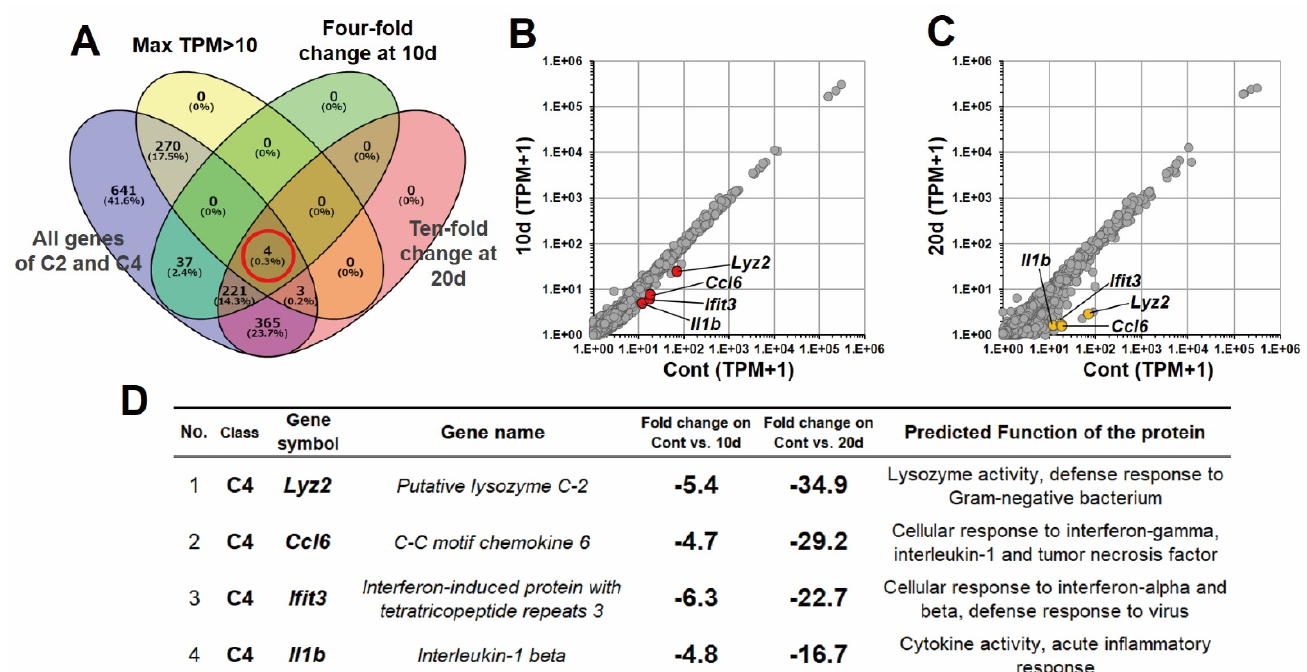
Figure 4. Identification of four candidate RNA markers in RBCs. ( A ) Venn diagram including conditions as follows: 4-fold change in averaged TPM values at 10 d, 10-fold change in averaged TPM values at 20 d, and maximum averaged TPM value > 10. ( B ) A scatter plot between Cont and 10 d. ( C ) A scatter plot between Cont and 20 d. The color dots show 4 genes of the candidate RNA markers obtained from the Venn diagram analysis. ( D ) A table including each characteristic of each candidate RNA marker.